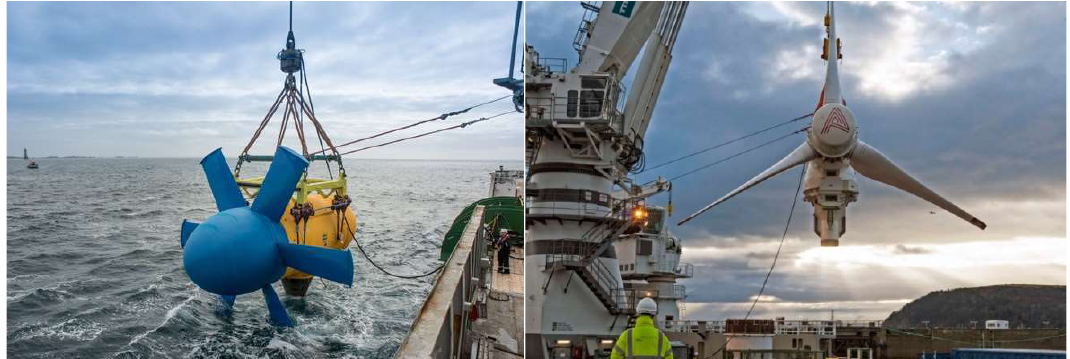
Figure 1. Sabella D10 (left) and Atlantis AR1500 tidal stream turbines (TSTs; right) [15].